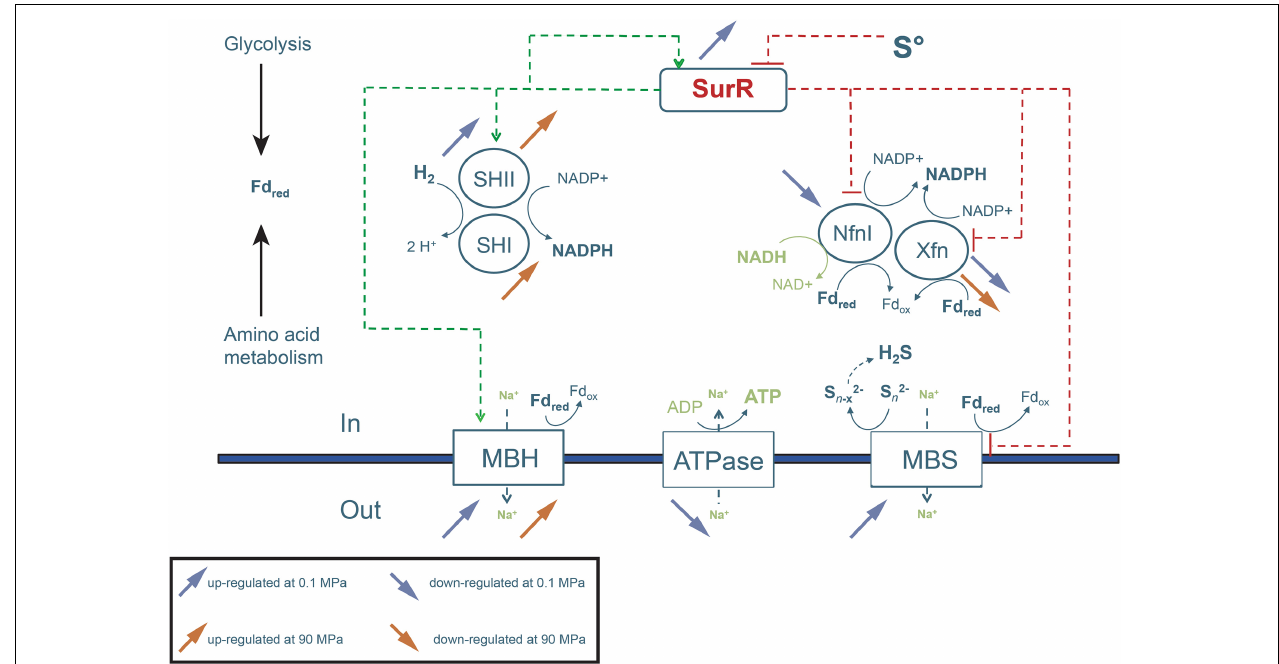
FIGURE 3 | Schematic representation of the main transcriptional metabolic regulations observed at sub-optimal (0.1 MPa) and supra-optimal (90 MPa) pressures for growth. This figure is centered on the general metabolism and focuses notably on hydrogenases and energy conversion processes and on their transcriptional regulator SurR, in the context of adaptive response to hydrostatic pressure. Blue and red arrows represent the overexpression (up direction) and subexpression (down direction) of genes at sub-optimal (0.1 MPa), and supra-optimal (90 MPa) pressures for growth, respectively, compared to the optimal pressure for growth (50